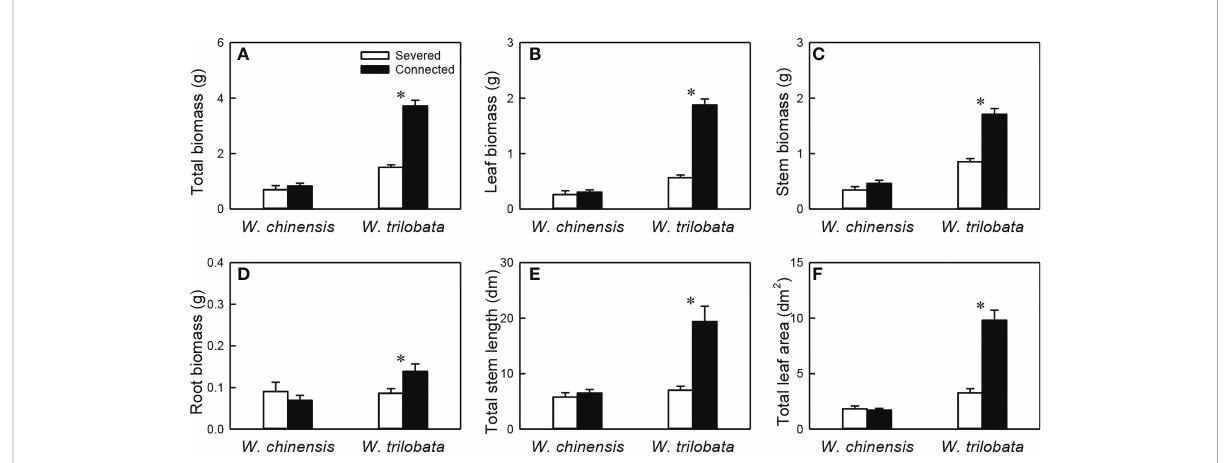
FIGURE 6 Total biomass (A) , leaf biomass (B) , stem biomass (C) , root biomass (D) , total stem length (E) and total leaf area (F) of the whole fragment of the invasive plant Wedelia trilobata and the native plant W. chinensis . Values are means ± SE. Symbols (* P < 0.05) indicate the signi fi cant differences between the severed ramets and connected ramets within a